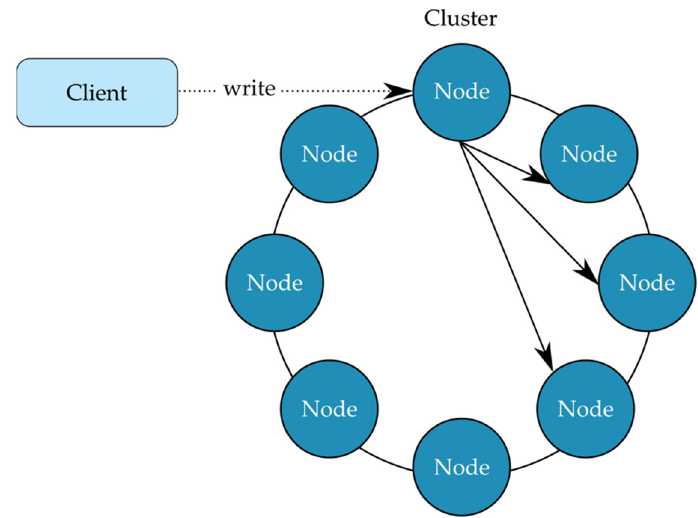
Figure 6. Cluster of Nodes in a Cassandra Cluster.